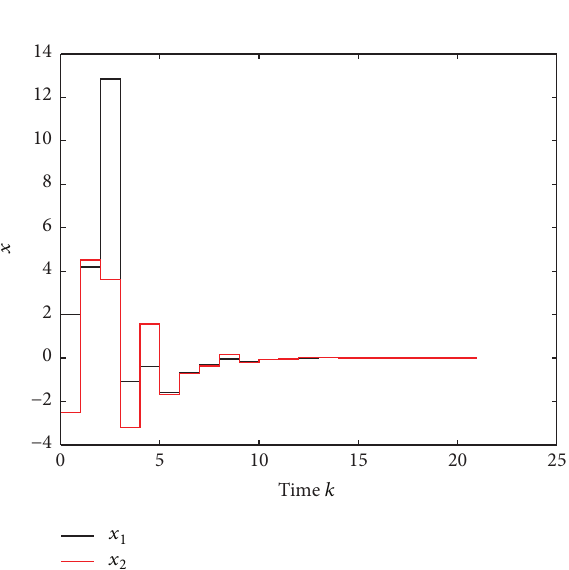
Figure 3: 𝑥(𝑘) of the system (1)–(5).